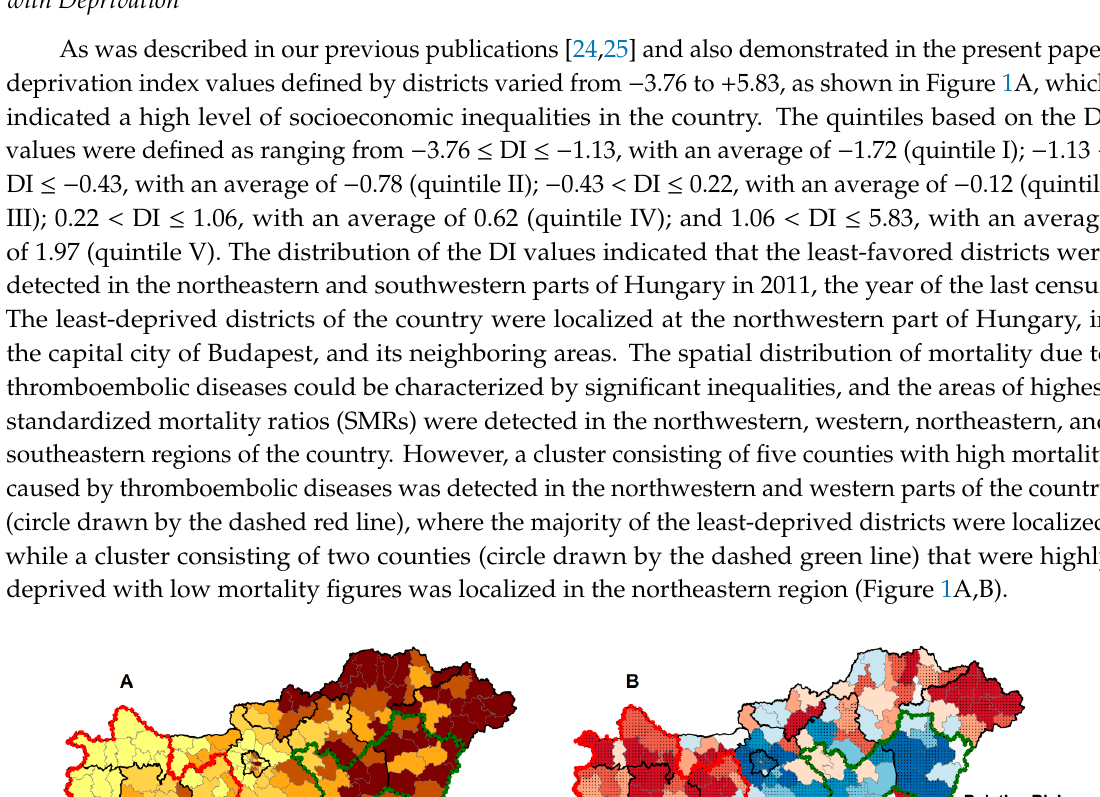
Table 1. Mortality risk due to thromboembolic diseases for 40–X age group of the population at the district level by deprivation index (DI) quintiles, Hungary,